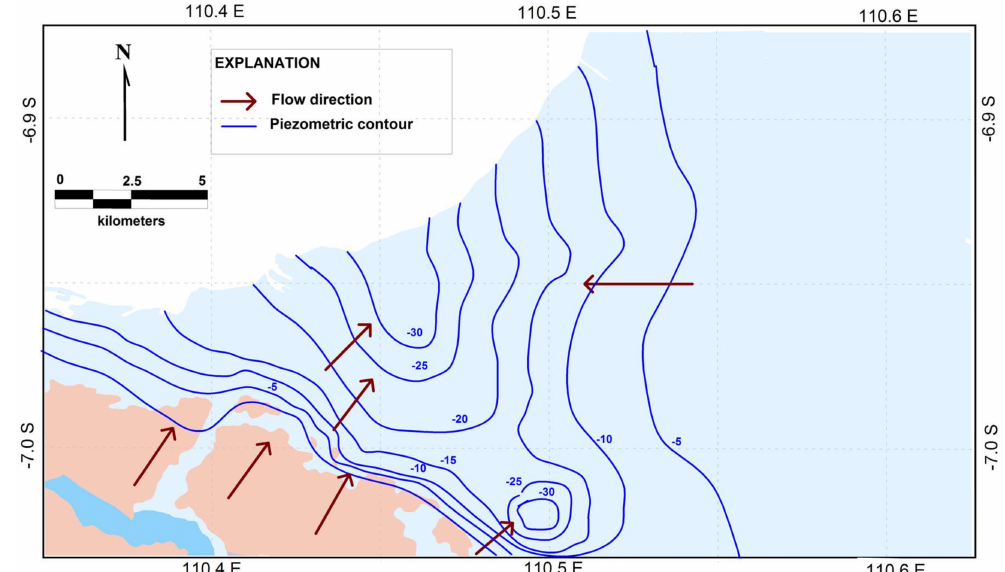
Figure 3. Piezometric contour of the Damar Formation aquifer (in m